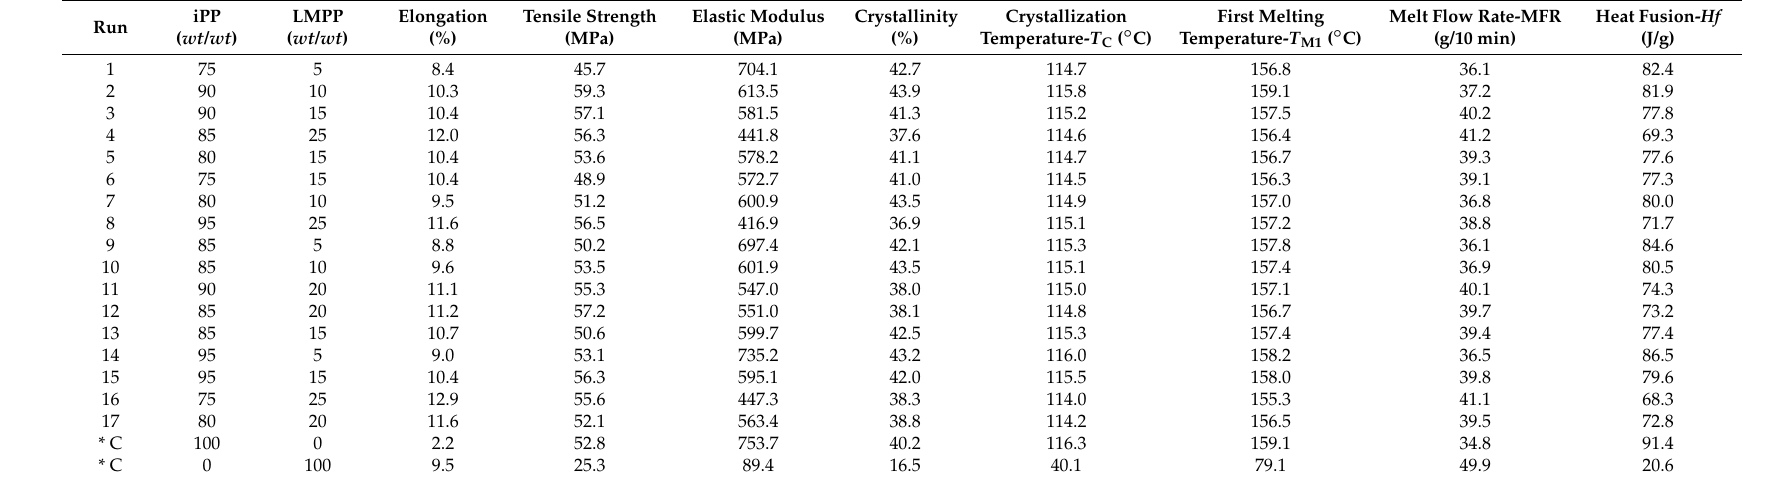
Table 2. The design of experiments and responses for iPP/LMPP